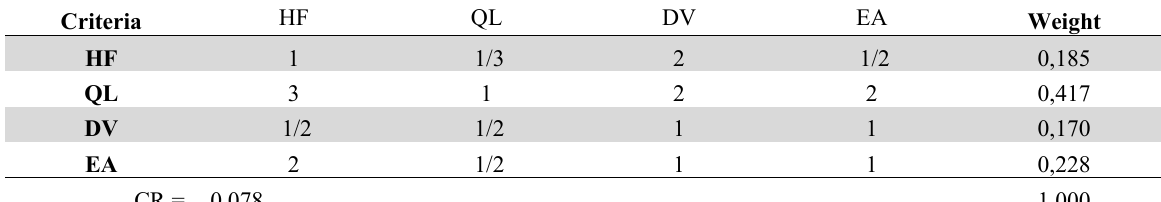
Pairwise comparison matrix aggregation for Socio-economics Vulnerability.